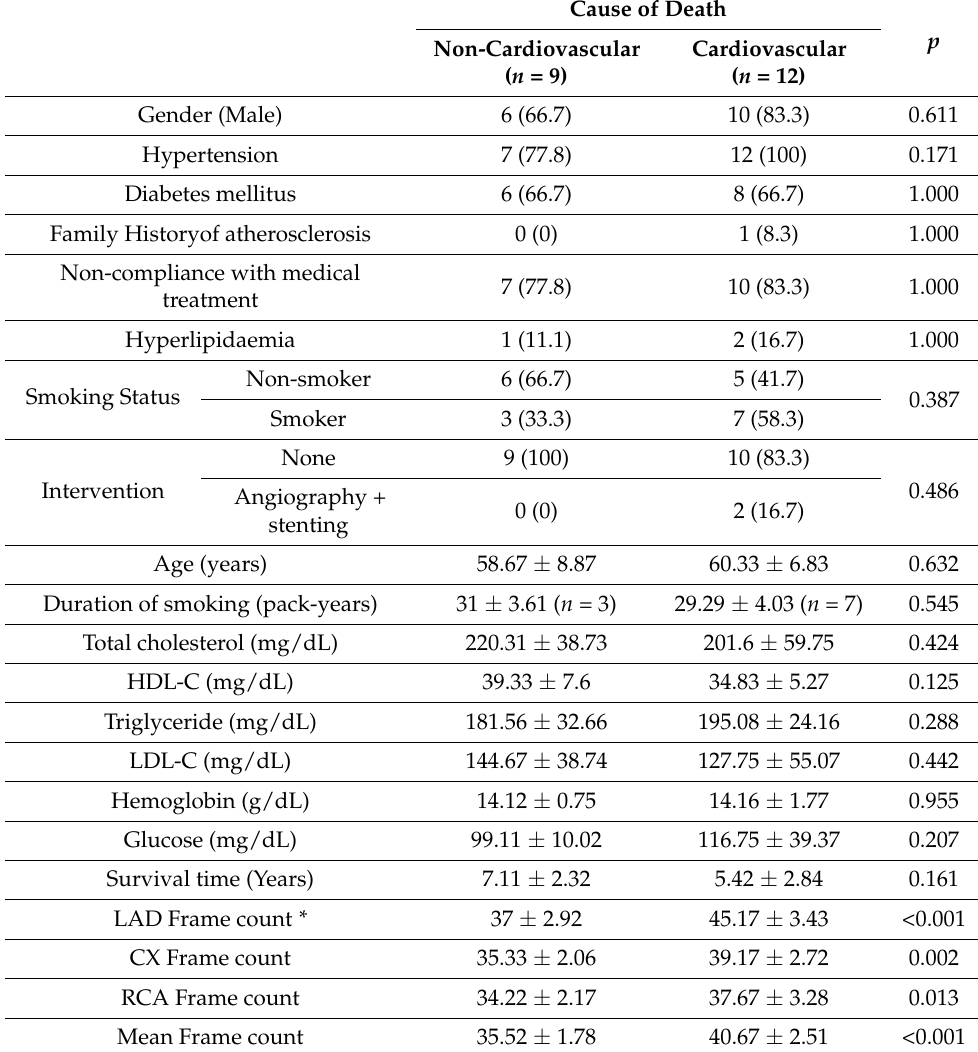
Table 2. Comparisons of the demographic and clinical characteristics of patients who died of cardiovascular vs. non-cardiovascular causes.